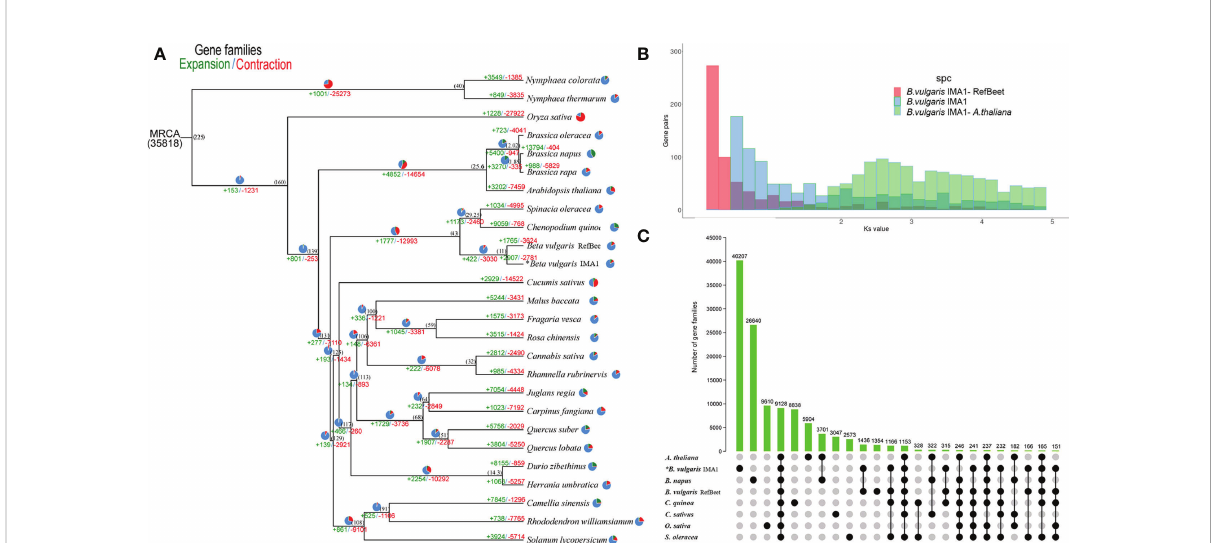
FIGURE 4 (A) Phylogenetic tree of gene families number unveiling expansion (green) and contraction (red) among 26 species. Pie diagrams represent the ratio of expanded (green), contracted (red), and conserved (blue) genes among whole gene families. The estimated divergence time